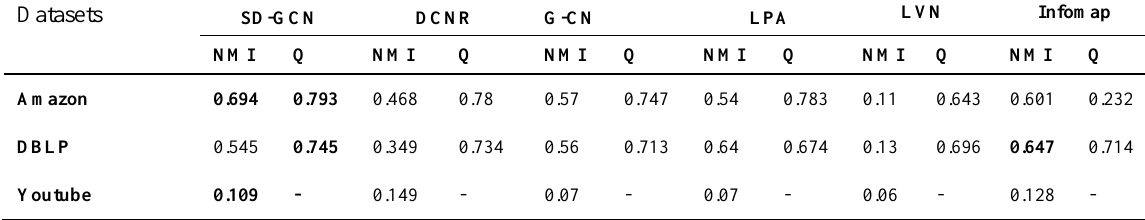
Table 5. Experimental results on large real-world networks with ground truth communities.